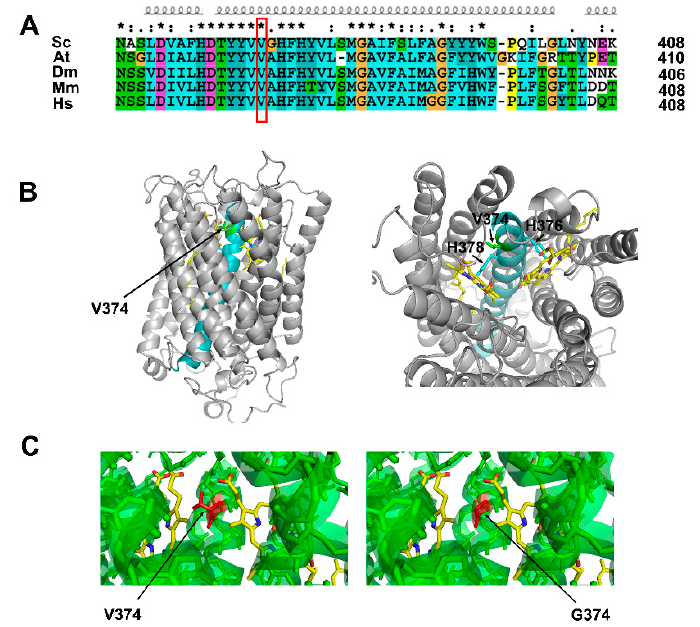
Figure 4. Cox1 p.Val374Gly mutation did not affect the protein tertiary structure. ( A ) Alignment of yeast Cox1 sequences containing Val374 in different species. Sequences of Saccharomyces cerevisiae (Sc) , Aradopsis thaliana (At) , Drosophila melanogaster (Dm) , Mus musculus (Mm) , and Homo sapiens (Hs) are aligned with ClustalX 2.1. Identical and conserved residues were marked with asterisks. Val374 is marked with a red rectangle, and the α -helices are marked on the top of sequences. ( B ) Side view ( left panel) and top view ( right panel) of Cox1 from Saccharomyces cerevisiae (PDB code: 6hu9). The transmembrane α -helix containing Val374 is colored in cyan, Val374 in green, His376 and His378 in blue, and two hemes in yellow. ( C ) Tertiary structure of wild-type yeast Cox1 (PDB code: 6hu9; left panel) and Cox1 p.Val374Gly mutation (predicted by SWISSMODEL; right panel). The transmembrane α -helix is colored in green, residue 374 in red, and two hemes in